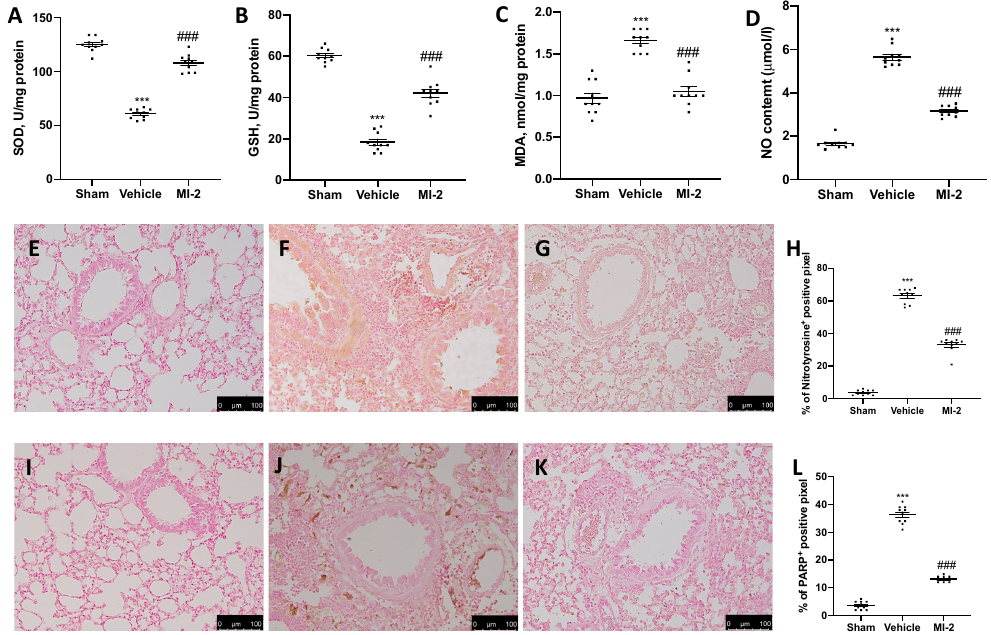
Figure 5. Effect of MI-2 on oxidative stress: SOD ( A ), GSH ( B ), MDA ( C ), NO content ( D ), immunohistochemical analysis of nitrotyrosine expression: sham ( E ), vehicle ( F ), MI-2 ( G ), % of positive pixels ( H ), immunohistochemical analysis of PARP: sham ( I ), vehicle ( J ), MI-2 ( K ), % of positive pixels ( L ). For each analysis, n = 10 animals from each group were employed.